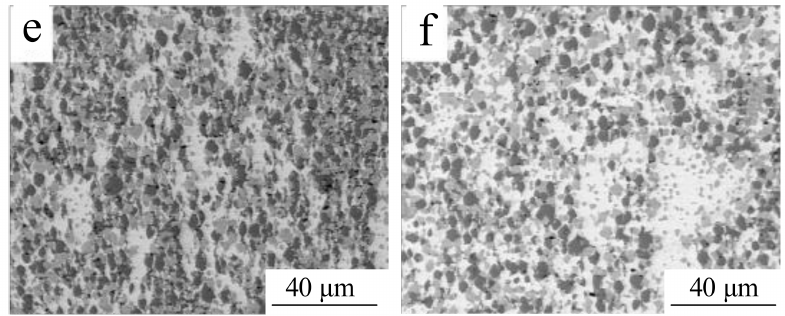
Figure 13. Backscattered electron images of Nb-5Si at different temperatures: ( a ) zone B at 1050 ◦ C; ( b ) zone C at 1050 ◦ C; ( c ) zone B at 1100 ◦ C; ( d ) zone C at 1100 ◦ C; ( e ) zone B at 1150 ◦ C; ( f ) zone C at 1150 ◦